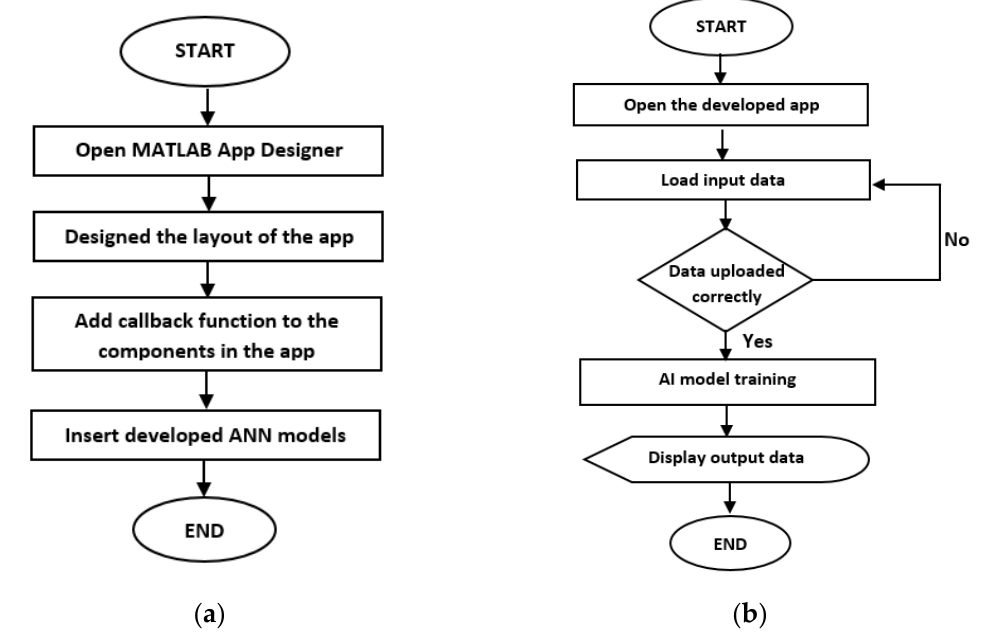
Figure 4. The flowcharts of ( a ) the app development process and ( b ) the real-time modelling